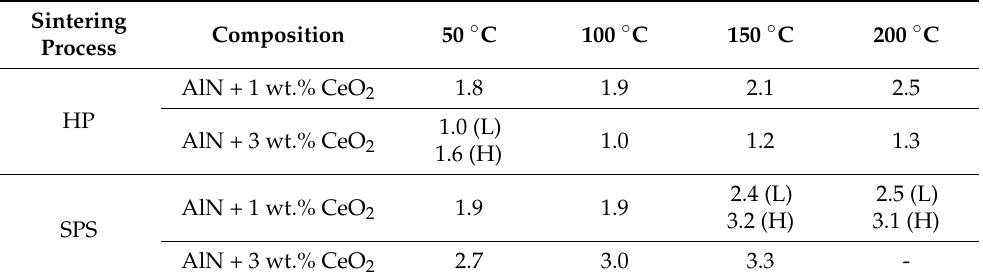
Table 4. Slopes calculated from the log–log representation of leakage current measurements obtained at different temperatures.